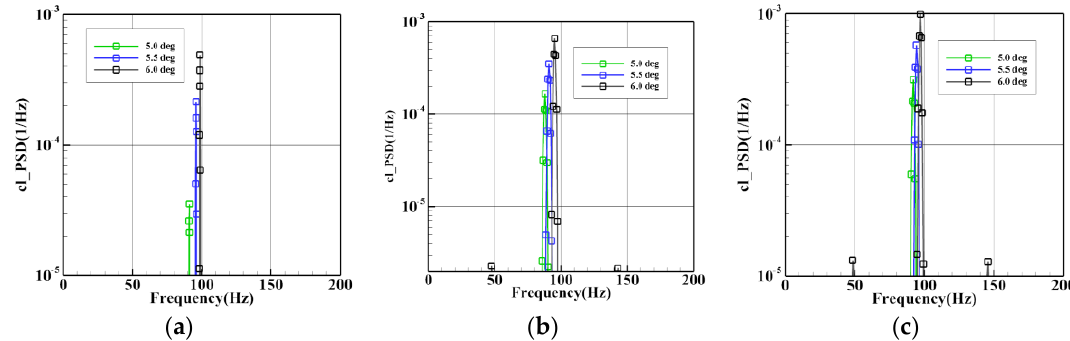
Figure 19. PSDs of unsteady lift coefficient histories under different blowing cases: ( a ) 41% x/c, ( b ) 46% x/c, and ( c ) 51% x/c.